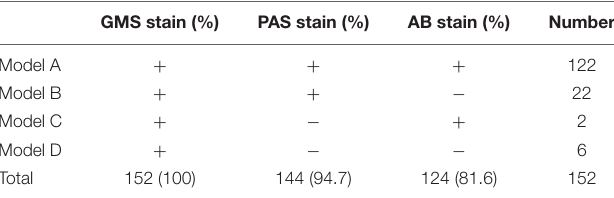
TABLE 3 | Positive rates of the three staining methods for pulmonary